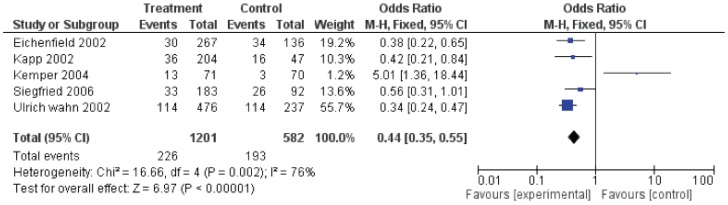
Analysis of Study withdrawals.